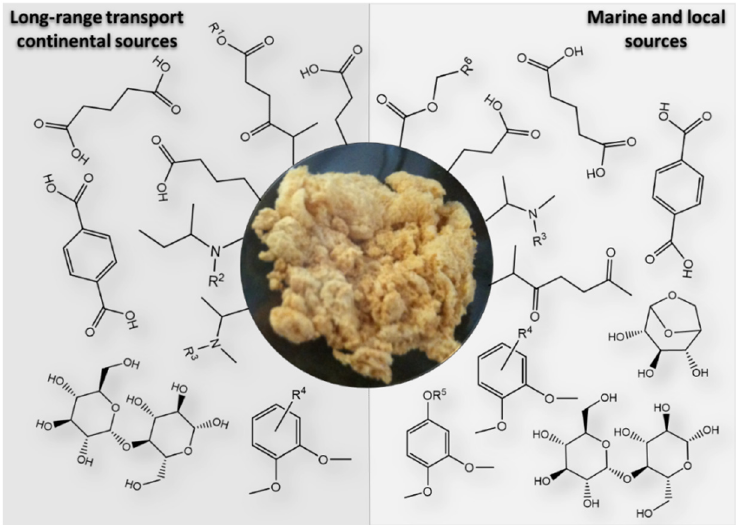
Figure 2. Structural model of two urban aerosol WSOM samples collected under different atmospheric conditions: long-range transport from continental sources and marine and local sources, exhibiting a ratio of aliphatic –CH 3 , C–CH 2 –C, –COO, aromatic C–O, and anomeric O–C–O of 5:11:7:2:2 and 4:8:6:4:3, respectively (R 1 to R 6 = H or alkyl group; photo: aerosol WSOM, after freeze-drying). Reprinted/adapted from Atmospheric Environment , 230, R.M.B.O. Duarte, P. Duan, J. Mao, W. Chu, A.C. Duarte, K. Schmidt-Rohr, Exploring water-soluble organic aerosols structures in the urban atmosphere using advanced solid-state 13 C NMR spectroscopy, 117503, Copyright (2020), with permission from